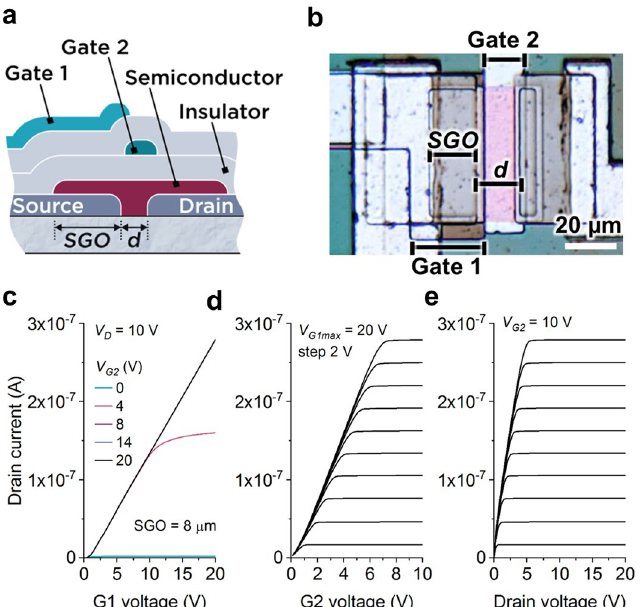
Figure 1. The multimodal transistor (MMT). ( a ) Illustrative cross-section and ( b ) optical micrograph of a microcrystalline silicon (µ-Si) multimodal transistor (MMT). Charge dynamics in the source-gate overlap ( SGO ) and source-drain separation ( d ) regions are controlled by the current control gate (Gate 1), and channel gate (Gate 2), respectively 19 . ( c ) Simulated amorphous silicon (a-Si) MMT transfer characteristics showing Gate 1 (G1) sets drain current magnitude, while Gate 2 (G2) allows or blocks its flow without influencing its magnitude. ( d ) Simulated transfer characteristics for G2 further demonstrating that G2 does not